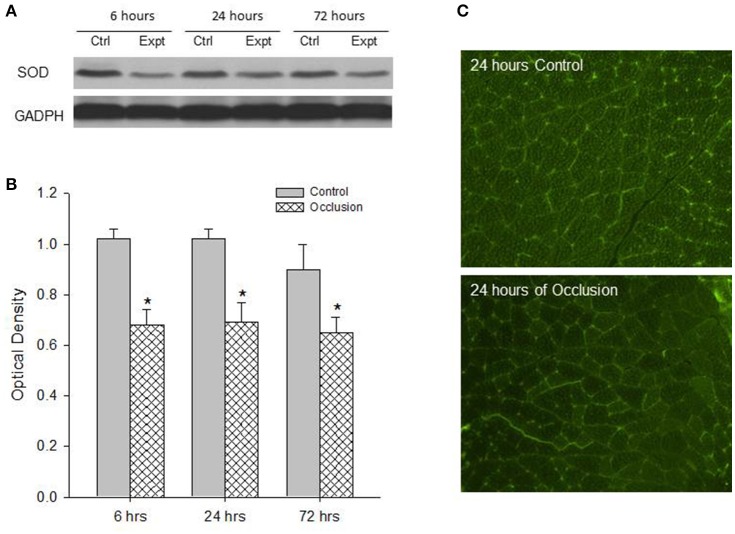
Analysis of SOD protein expression in the white muscle tissues of control limbs and limbs with 6–72 h of femoral artery occlusion. (A,B) Representative bands and average data of western blot analysis show that the less SOD is observed in occluded limbs. Bands of GADPH were used as a control for equal protein loading *P < 0.05 vs. control group, n = 6 in each group. There was no significant difference in SOD expression observed among different time courses. (C) Typical images of immunofluorescence show that SOD is localized in the white muscles and the less fluorescence staining is observed in the muscle of occluded limbs.